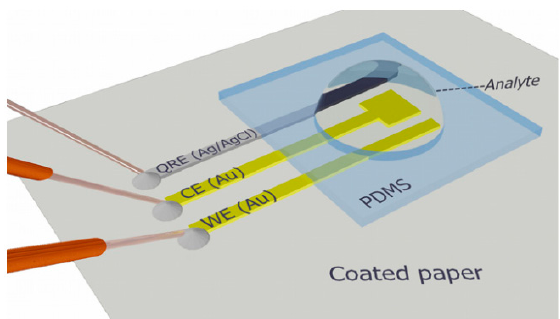
Figure 5. The schematic diagram of the inkjet-printed electrochemical sensor on paper developed by Maattanen et al. Reproduced with permission from [14], Copyright Elsevier, 2017.